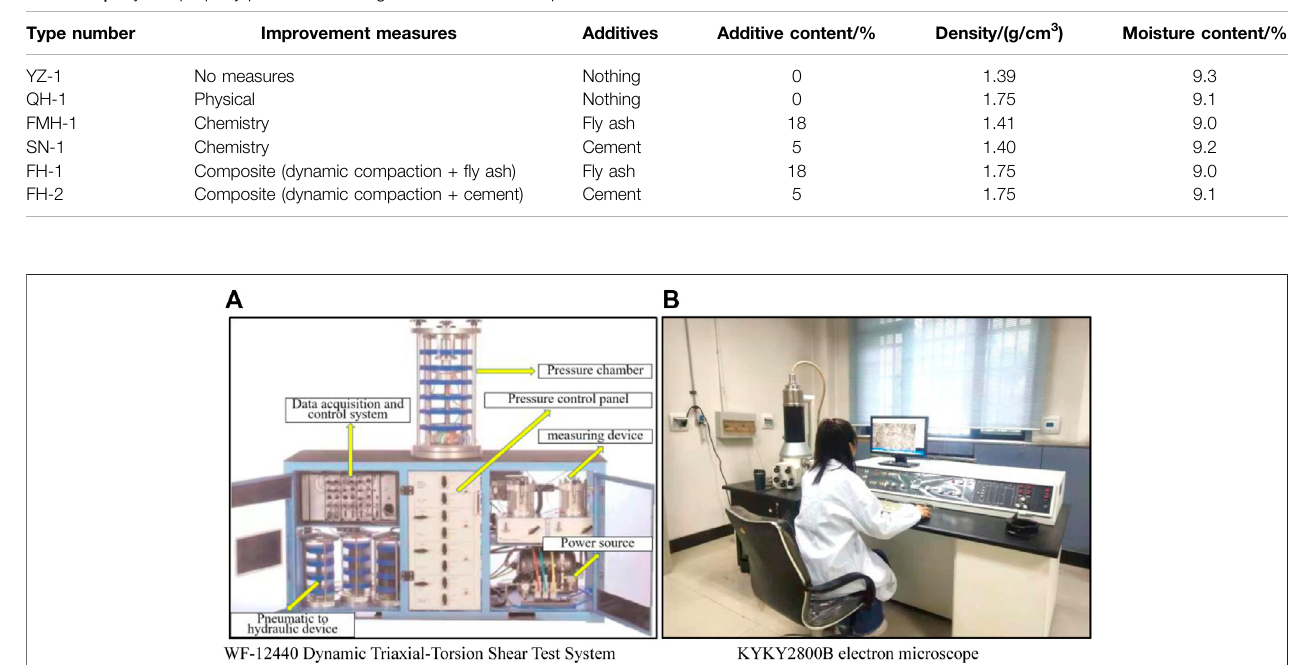
TABLE 2 | Physical property parameters of original and modi fi ed